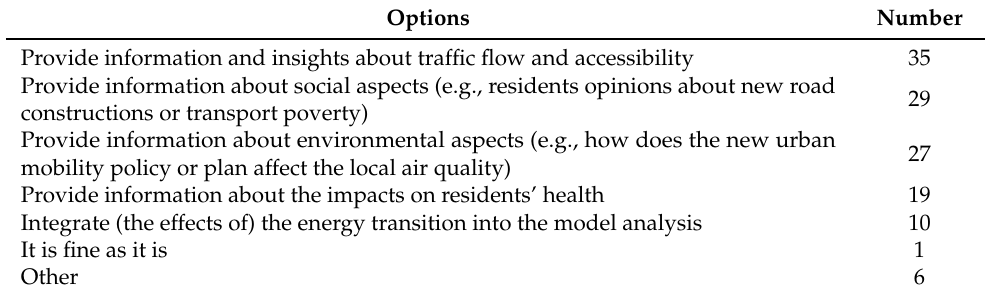
Table 3. The type of information that respondents consider GIS models should provide to support urban mobility planning (more than one answer possible, N = 45 respondents). Options Number 35